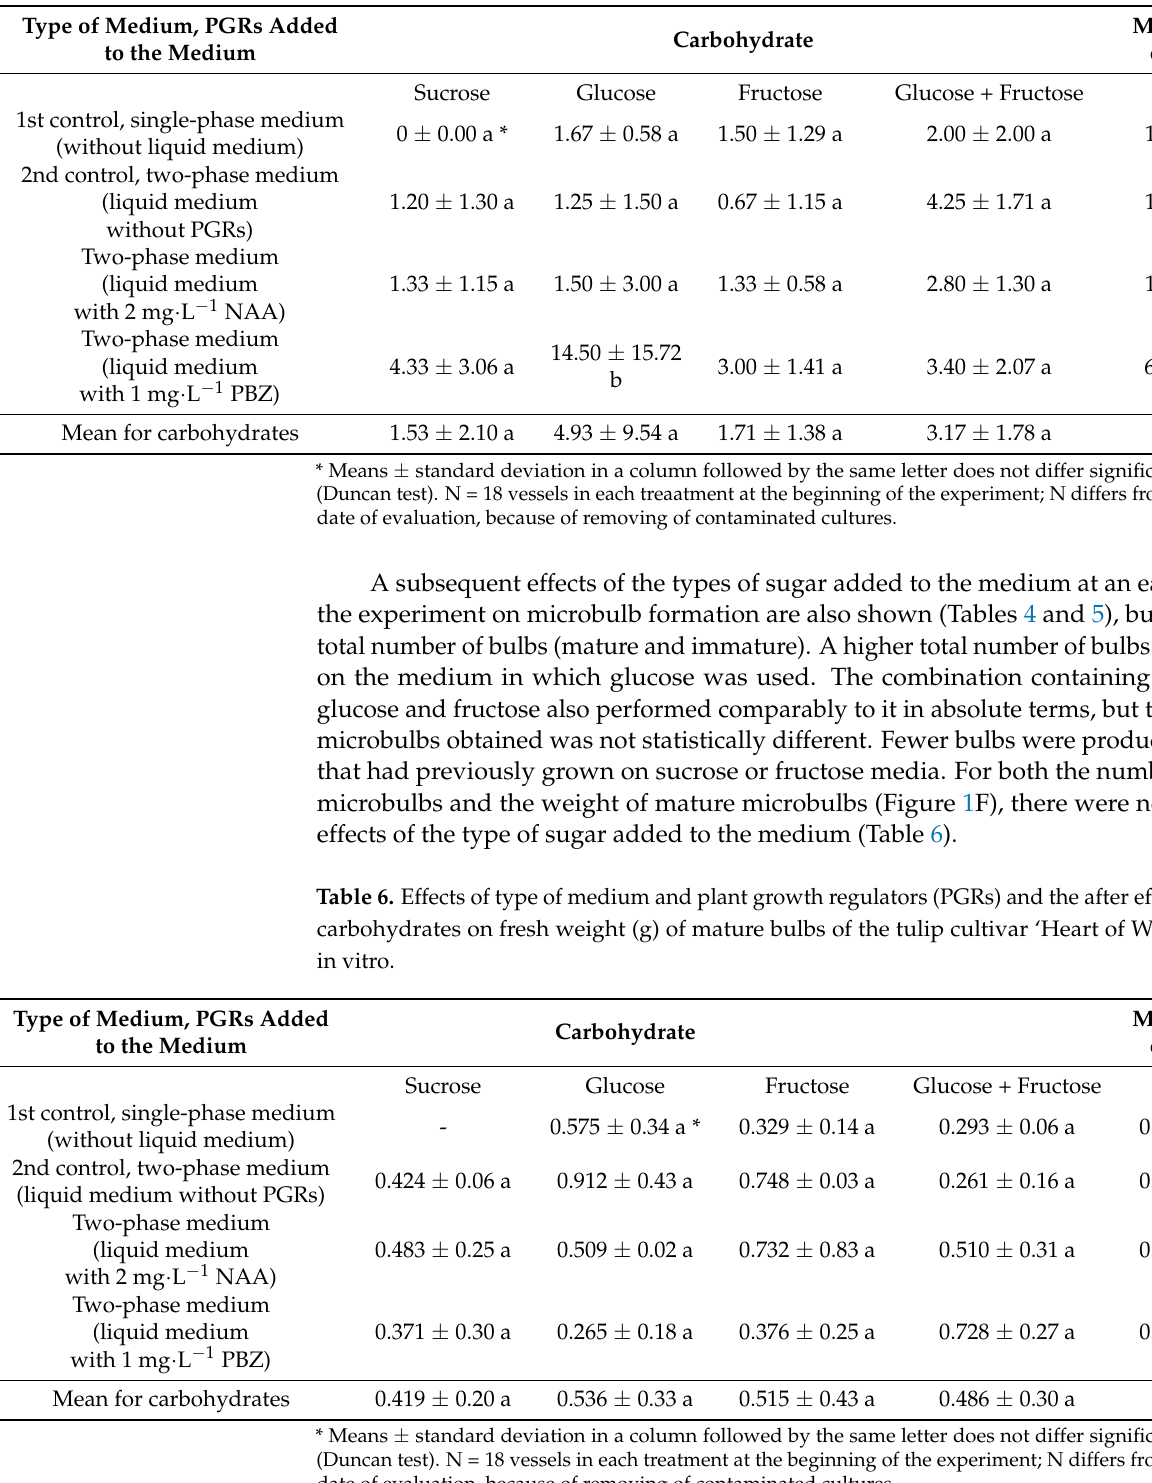
Table 5. Effects of the type of medium and plant growth regulators (PGRs) and the after effect of different carbohydrates on the number of mature bulbs of the tulip cultivar ‘Heart of Warsaw’ formed in vitro.